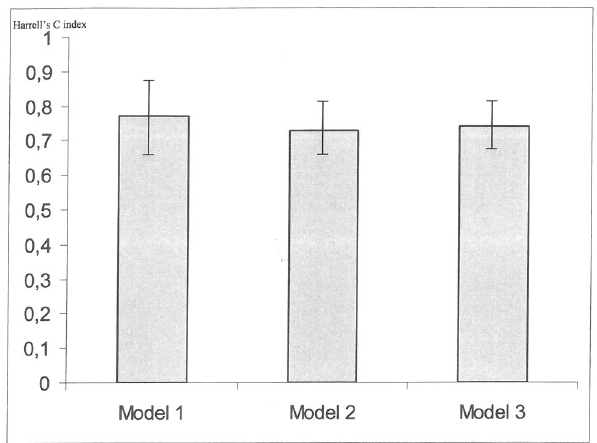
Figure 5. Harrell’s C index according to the Cox models (Model 1: Ln free PCS + aortic calcification + CRP + Hb; Model 2: Ln free IS + aortic calcification + CRP + Hb; Model 3: Ln free PCG + aortic calcification + CRP + Hb).